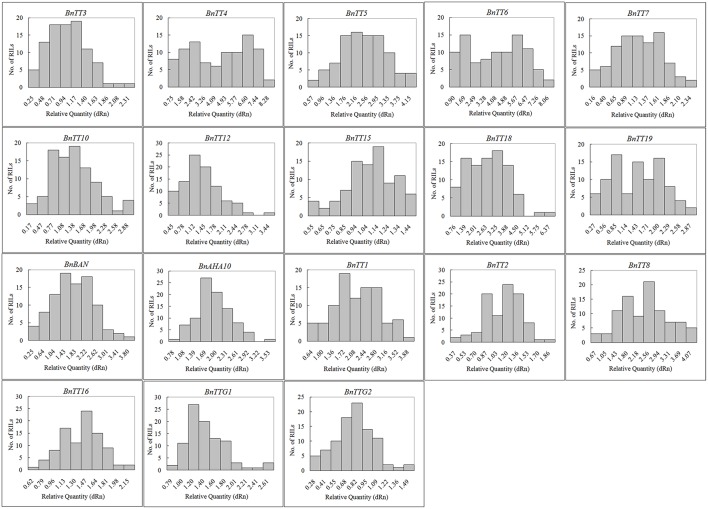
The frequency distribution of relative expression levels of flavonoid biosynthesis genes in B. napus. Abscissa: Relative expression level of each gene, Ordinate: The number of lines.